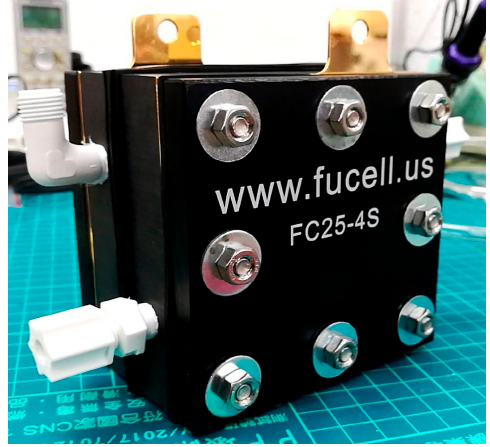
Figure 11. The proton battery.